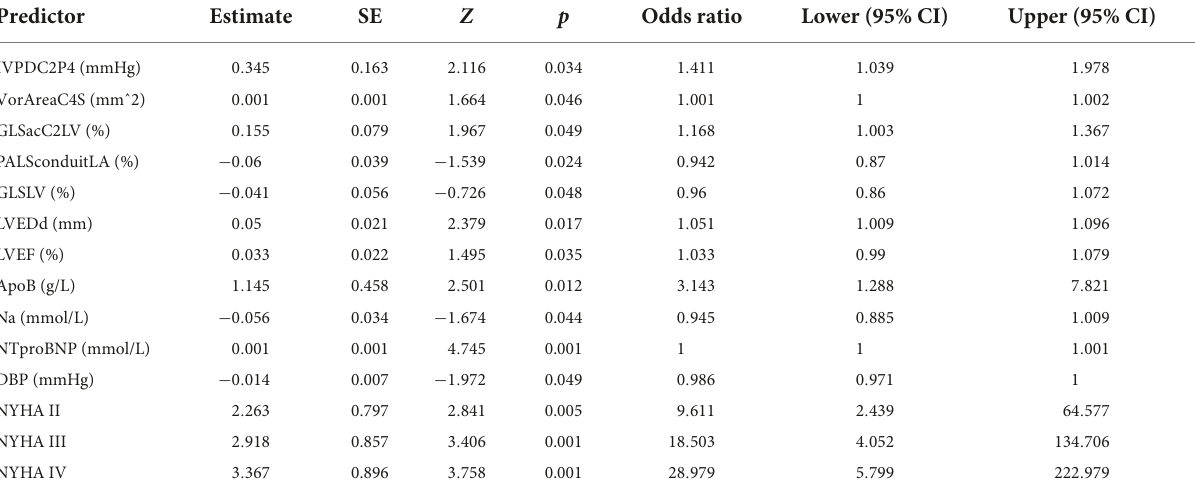
TABLE 5 Prognostic model for major cardiovascular events (MACE) based on logistic regression model. Predictor